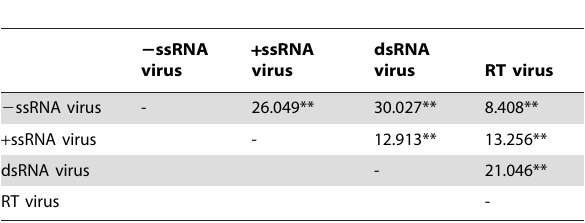
Table 2. Pair-wised variance analysis CpG usage between viral